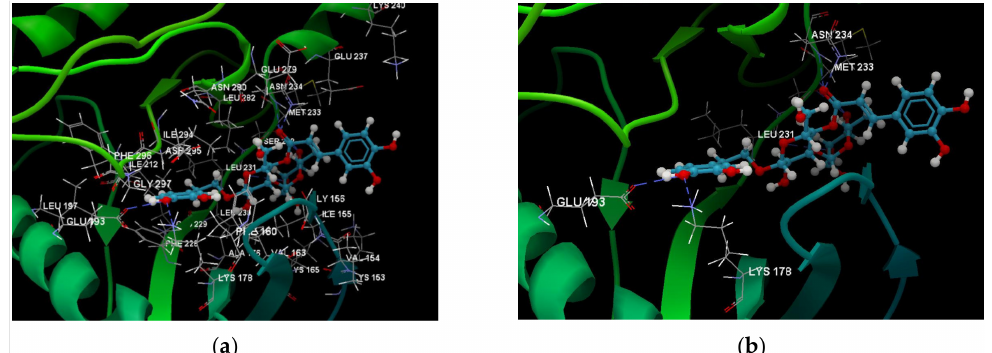
Figure 1. Interactions between verbascoside and the amino acid residues from the active binding site of 5ZTN: ( a ) general docking image of the verbascoside ligand interacting with the amino acid residues of the binding site of 5ZTN; ( b ) the hydrogen bonds between verbascoside and GLU 193, LYS 178, LEU 231, SER 232, MET 233, ASN 234 and ASN 280 active amino acids (CLC).